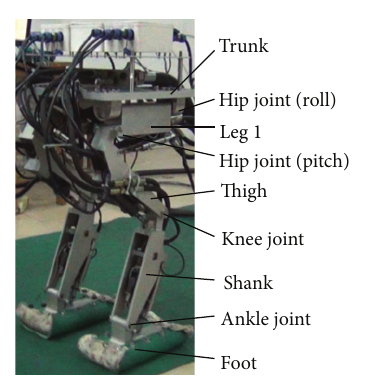
Figure 1: The physical prototype.